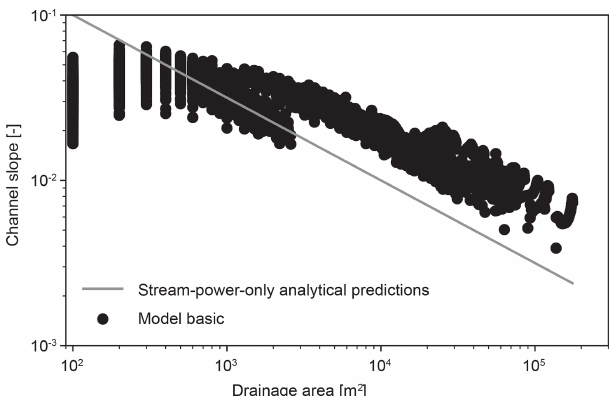
Figure 2. Slope–area relationship for the example simulation in Fig.